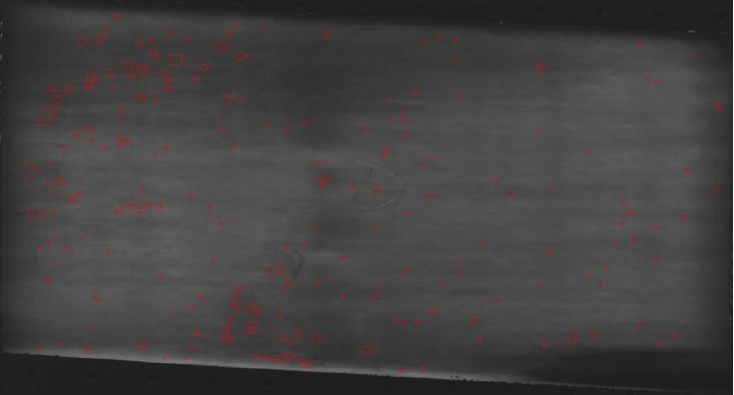
Figure 8. Candidates of pit defects through extracting features and localizing bounding boxes.